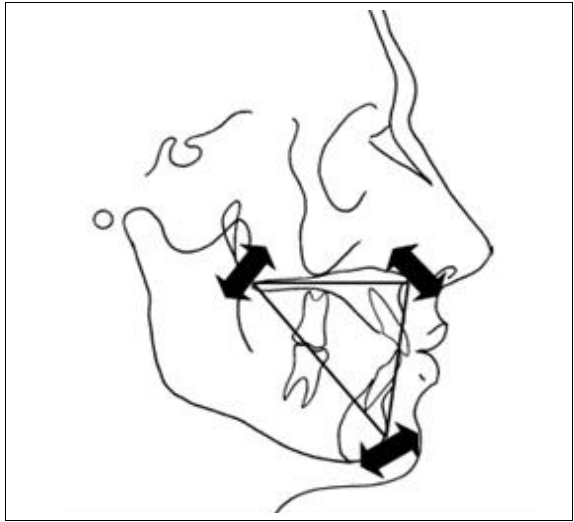
Figure 7. 11 Rotation of the maxillomandibular